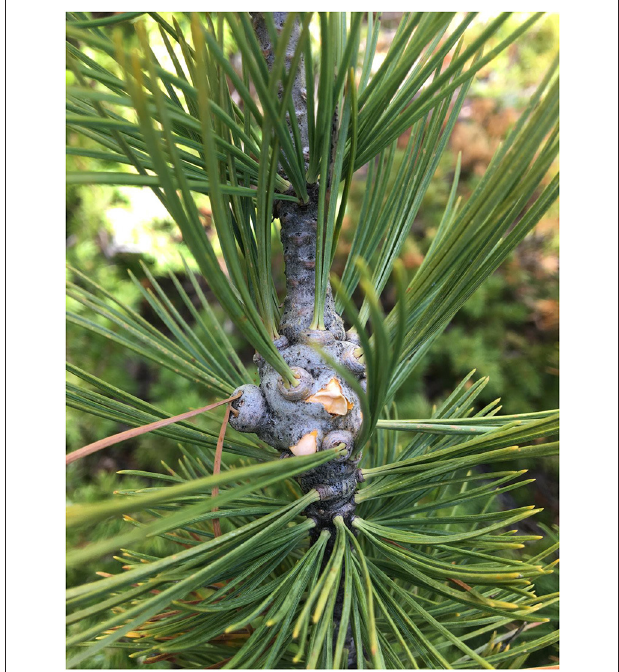
FIGURE 2 | Invasive disease: white pine blister rust. White pine blister rust (WPBR), a lethal forest disease caused by the fungus of Asian origin Cronartium ribicola , has had widespread impacts on North American five-needle pines. Introduced to the Americas in approximately 1900, the disease has led to permanent changes in ecosystems that contain susceptible pine species. These effects range from forest industry collapse to species endangerment to threatening wilderness character (e.g., Tomback et al., 2001; Fins et al., 2002). Management to restore impacted pine populations and proactive interventions to mitigate the development impacts and promote adaptive capacity in threatened ecosystems are underway (e.g., Keane et al., 2012; Schoettle et al., 2019a ). Combining statistical and mechanistic relationships into models has integrated field monitoring data with specific biological requirements of the pathogen, host and disease to reduce uncertainty about disease risk, development, and impacts (e.g., Kearns et al., 2014 ). Sensitivity analyses have further highlighted key factors affecting host population sustainability ( Field et al., 2012; Landguth et al., 2017). The arrangement of impacts on the landscape and conditional probabilities of WPBR infection can affect the public’s opinion and willingness-to-pay for management and the optimal timing and arrangement of management treatments (e.g., Shanahan et al., 2020). As these models become more complex and applicable at the landscape spatial scale and management’s temporal scale, they will be important tools for exploring when, where, and how to conduct management interventions for the greatest likelihood of successfully sustaining the pine populations in the persistent presence of the pathogen and meeting societal expectations for these mountain top ecosystems (Schoettle et al.,